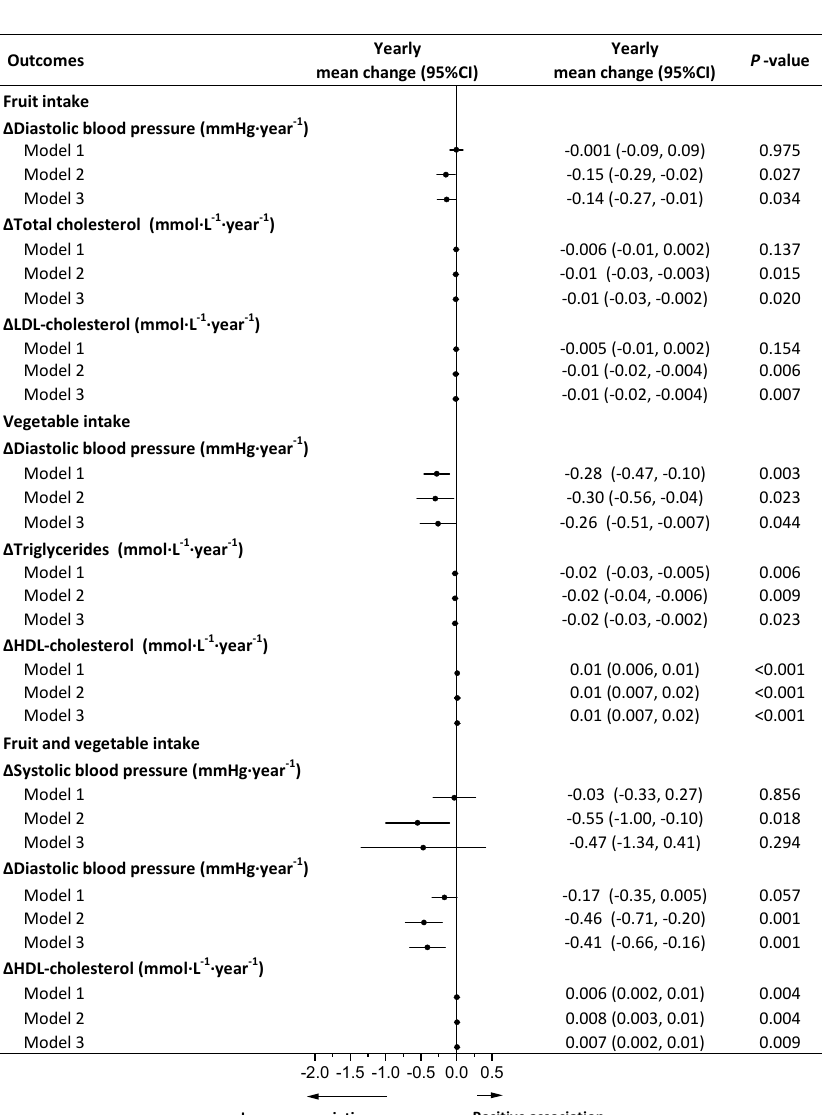
Figure 4. Longitudinal associations of fruit (50 g · day − 1 ) or vegetable (100 g · day − 1 ) or fruit and vegetable intake (150 g · day − 1 ) with yearly changes in cardiometabolic risk factors during weight-loss maintenance. Yearly mean change and 95% CI of main effects indicating changes in cardiometabolic risk factors per year associated with 50 g increment in fruit intake or 100 g increment in vegetable intake or 150 g increment in fruit and vegetable intake. Analyses were conducted using a linear mixed model with repeated measures. Model 1 was adjusted for fixed factors including age, sex, ethnicity, BMI at 8 weeks, cardiometabolic risk factors at 8 weeks, and time and random factors including study center and participant ID. Model 2 was adjusted for covariates in model 1 plus fixed factors including time-varying physical activity, energy intake (kJ·day − 1 ), alcohol intake (g·day − 1 ), animal-based food intake (g·day − 1 ), and other plant food intake (g·day − 1 ); for systolic blood pressure and diastolic blood pressure, model 2 was additionally adjusted for dietary sodium intake (g·day − 1 ). Model 3 was adjusted for covariates in model 2 plus time-varying yearly changes in body weight as a fixed factor. HDL cholesterol, high-density lipoprotein cholesterol; LDL cho- lesterol, low-density lipoprotein cholesterol.